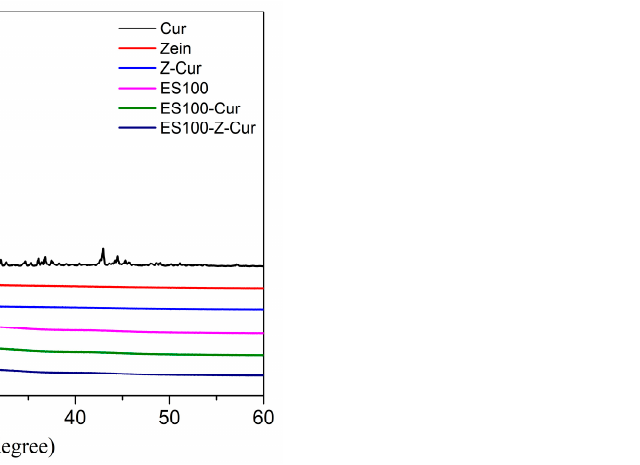
Figure 4. XRD patterns of pure Cur, zein, released self-assembled Z–Cur, ES100, ES100–Cur, and ES100–Z–Cur.